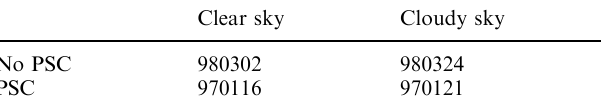
Table 2. Days (YYMMDD) of ideal observational conditions Clear sky